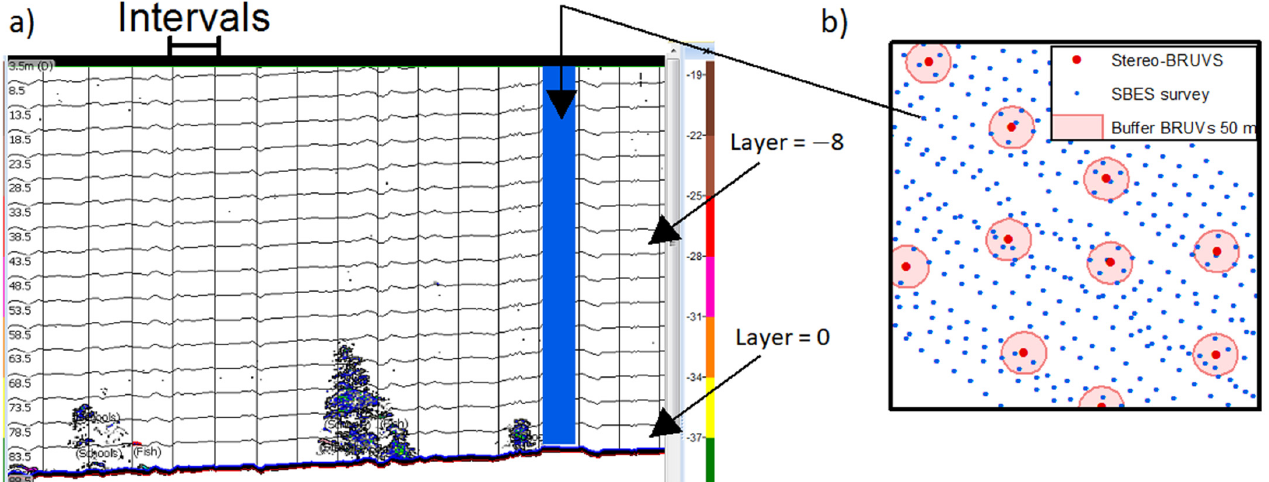
Figure 2. Example of the extraction of acoustic data to be compared with the stereo-BRUV data. ( a ) S v mean echogram where the acoustic energy was exported using a grid with intervals of 50 m long and 5 m deep layers. Each interval is represented on the left panel ( b ) as a blue dot. ( b ) Different radii of search around the stereo-BRUVs were used to extract the acoustic data, and a 50 m radius is shown as an example.